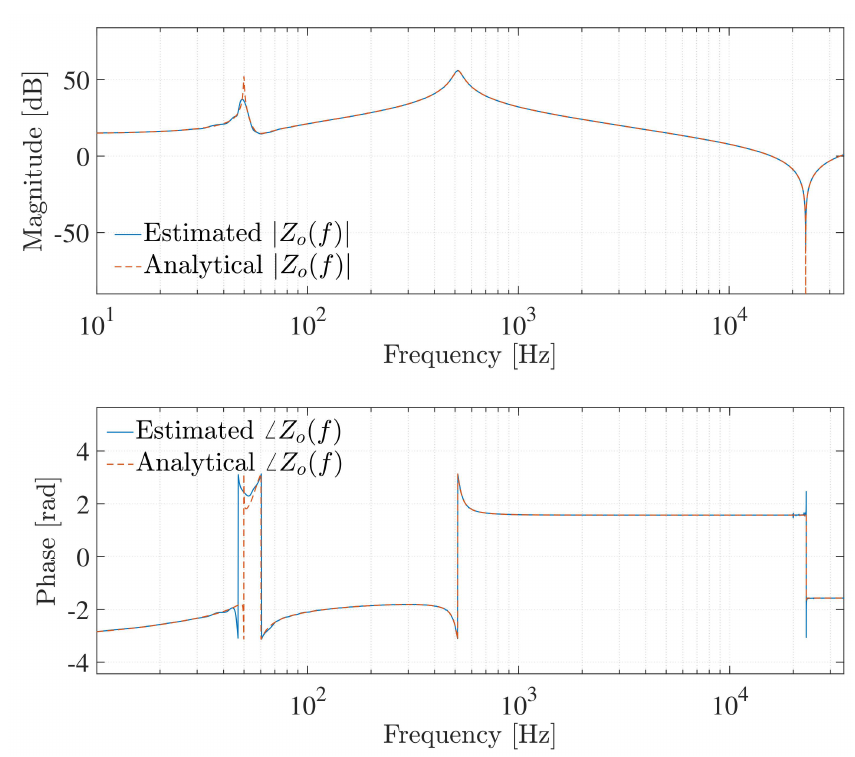
Figure 5. Magnitude and phase frequency response of the estimated inverter output impedance compared to the analytical inverter output